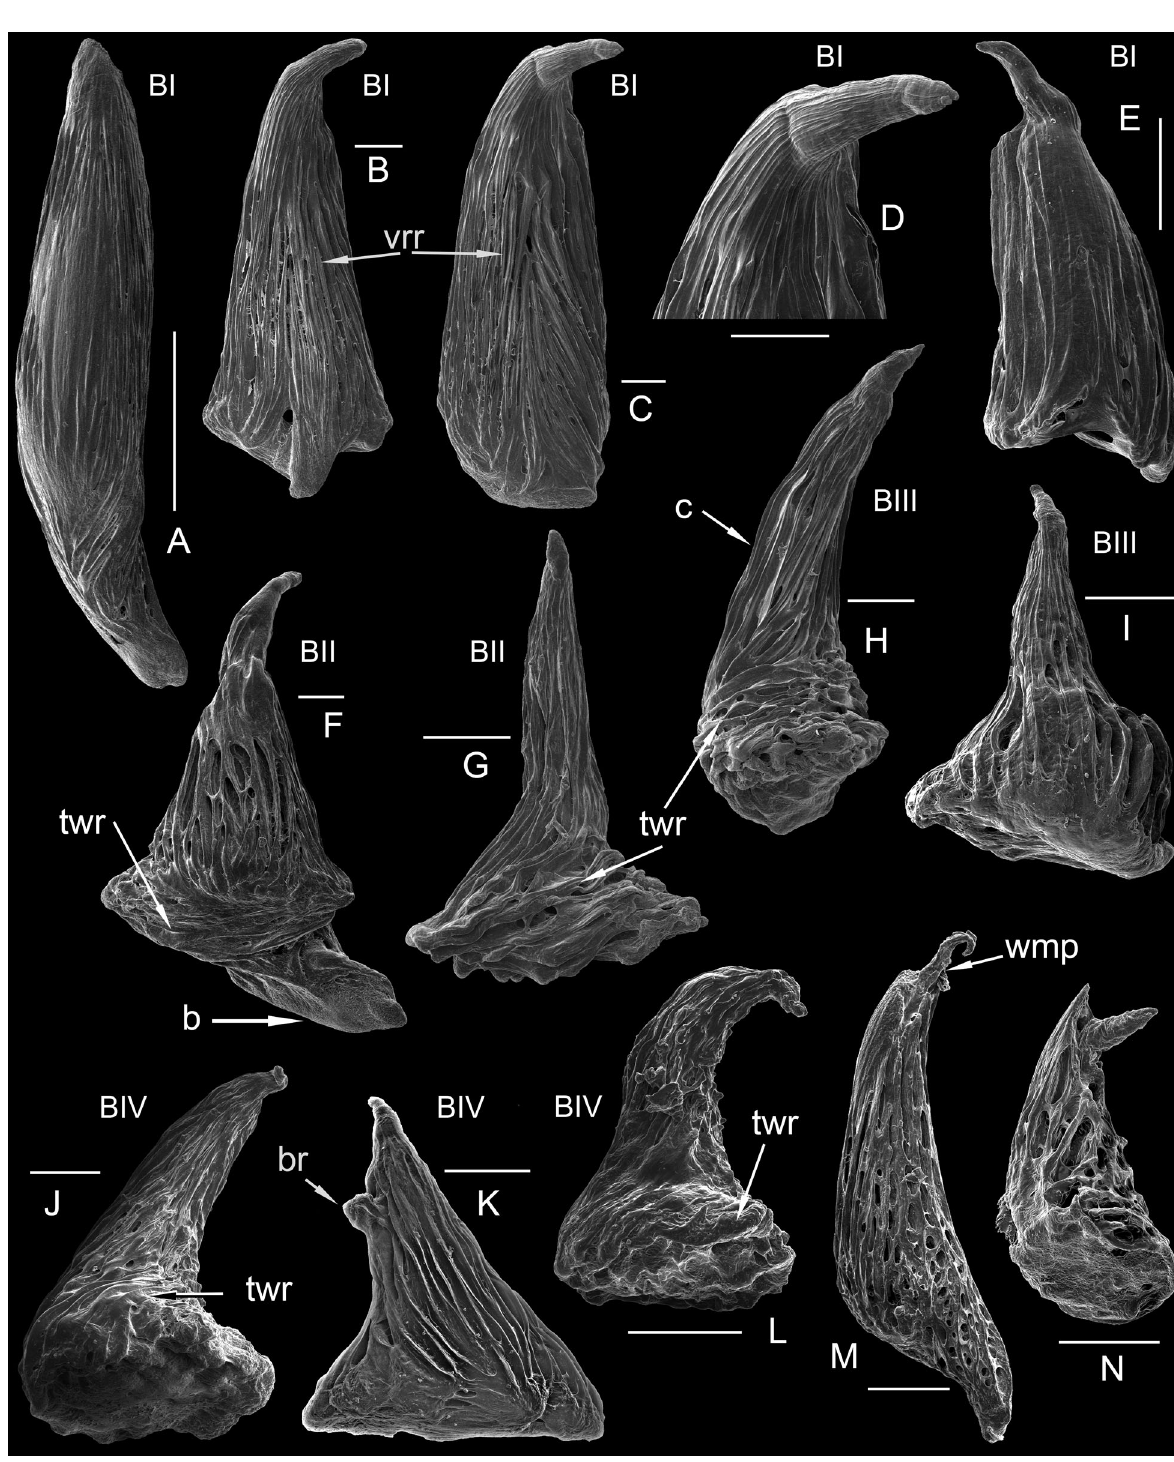
Fig. 8. Platichthys flesus trachurus (Duncker). Cores of gill rakers from the 1st to 4th arches of the blind side (BI–BIV). A, GIT 584-118-5; B, GIT 584-118-6; C = D, GIT 584-118-4; E, GIT 584-117-7; F, GIT 584-118-11; G, GIT 584-118-12; H, GIT 584-118-14; I, GIT 584-118-17; J, GIT 584-118-23; K, GIT 584-118-24; L, GIT 584-118-25; M, GIT 584-93-10; N, GIT 584-93-14. Scale bar for A is 1 mm, for B–N 200 µm. Abbreviation: twr, twisted ribs of gill raker core. For other abbreviations see Fig.